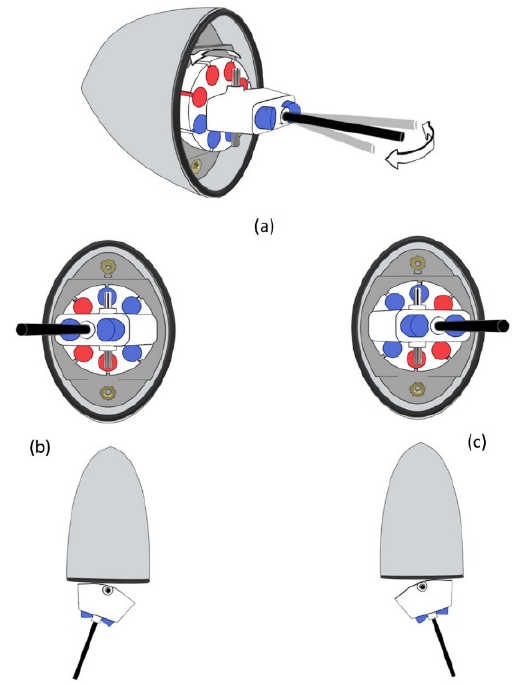
Figure 2. Magnetic mechanism. The micro DC gear motor placed inside the head gives rotative motion to a plastic disc. Permanent magnets were inserted into the disc ( a ). The magnets on the right and left sides of the disk had opposite polarities (represented by red and blue). The oscillating unit had one magnet on each side with the same polarity orientation (represented in blue). When one of these magnets is attracted to those on the disc, the other is repulsed. The plastic rod (represented in black) always points to the side of the attracted magnet ( b , c ).